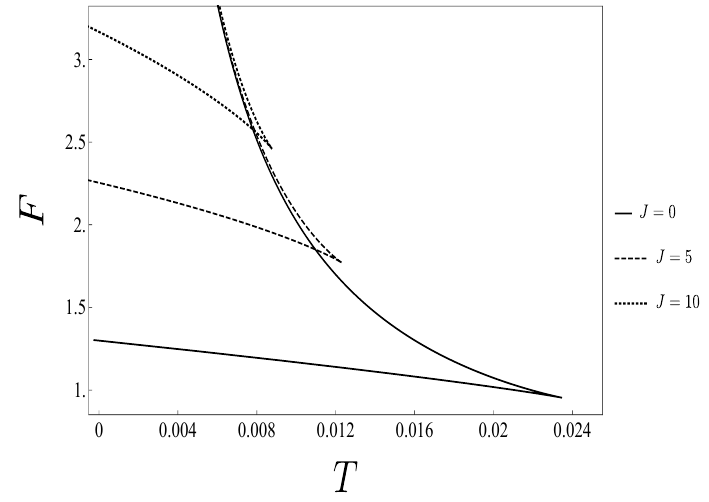
Figure 2 . Gibbs free energy: charged case. The F (cid:0) T diagram is displayed for (cid:12)xed n = 1, Q e = 1, and various angular momenta. The behavior of F resembles that of the charged(-rotating) black